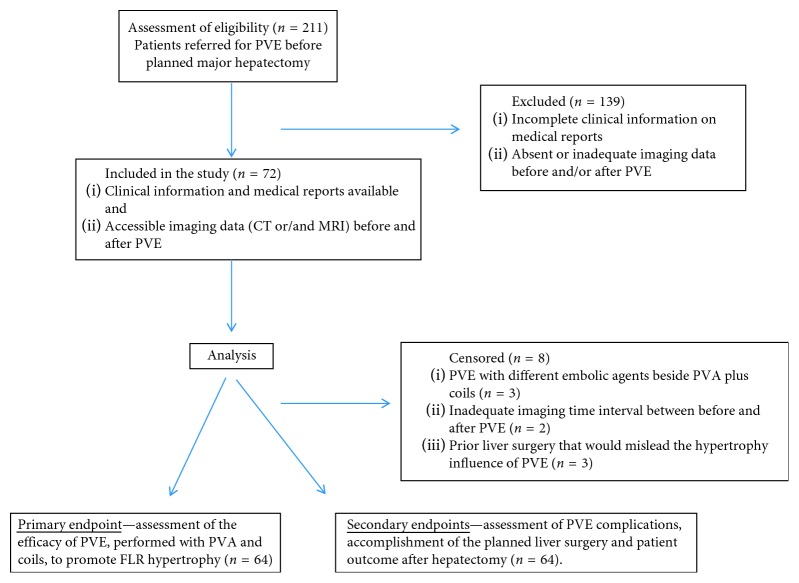
Patient flow chart.